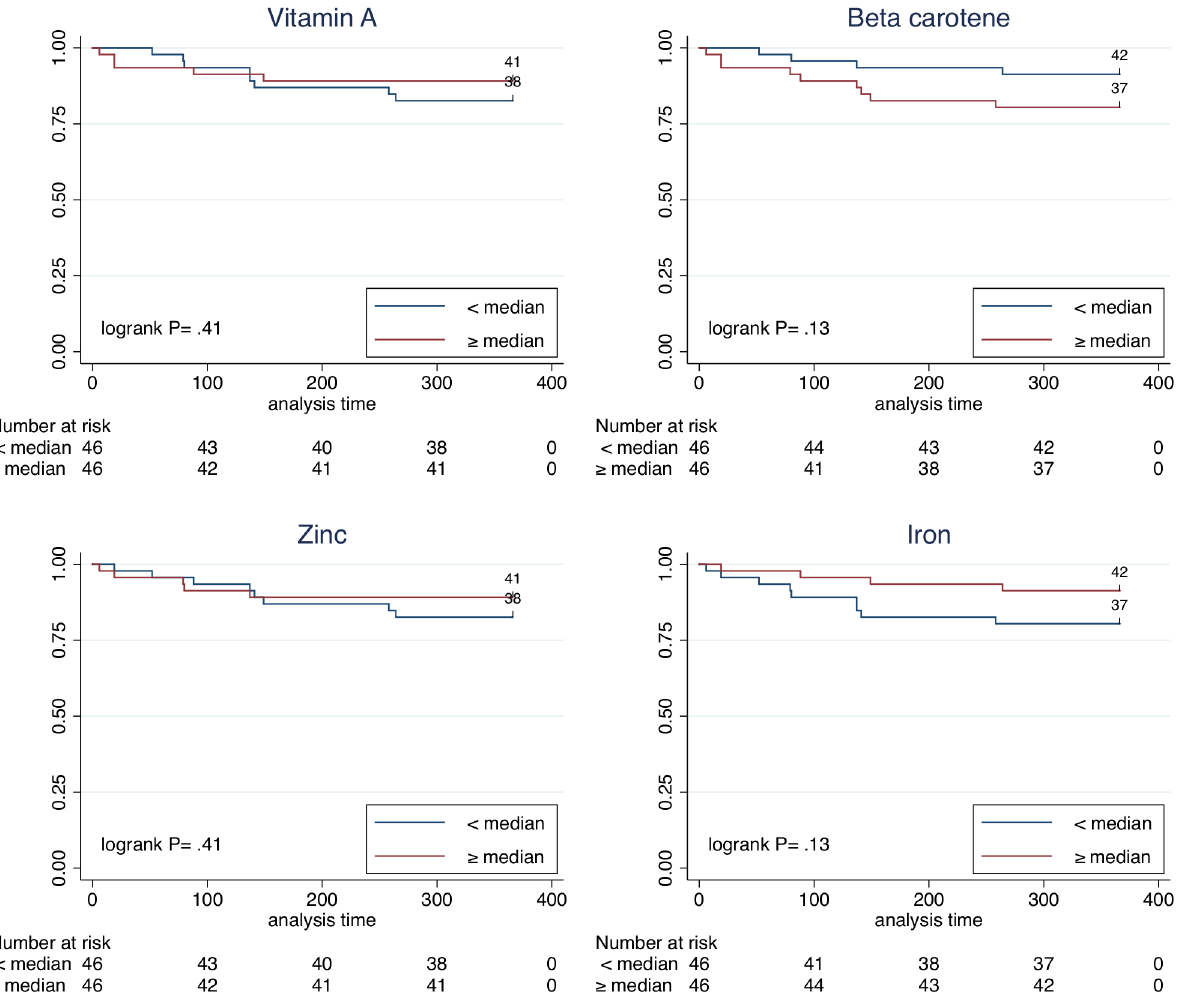
Fig 2. Survival analysis of time to first Plasmodium vivax malaria episode. Time to the first malaria episode was similar between participants with micronutrient levels above or below the median, for vitamin A, beta-carotene, zinc and iron.